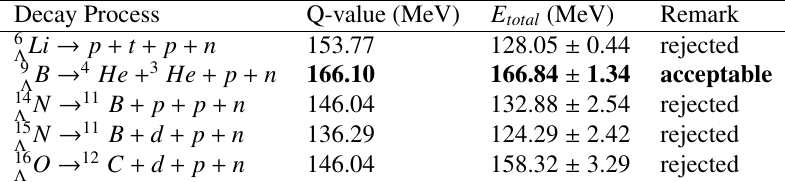
Table 2. The comparison of the Q-value and total kinetic energy ( E total ) of non-mesonic decay modes. Decay